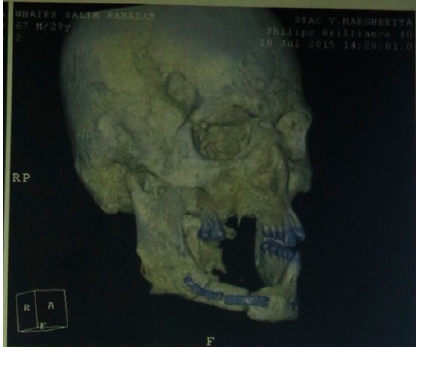
Figure 8. ( a ) 3D imaging before prosthetic treatment; ( b ) Rx imaging after implant surgery. Three- dimensional, (3D).